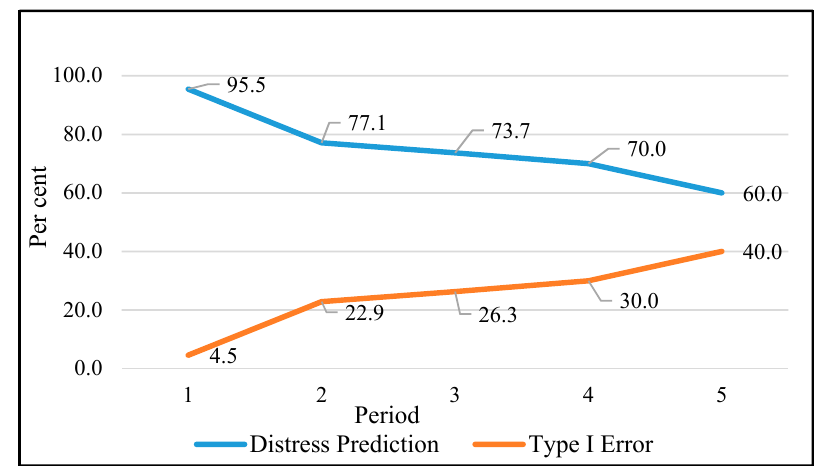
Figure 2. N period ahead prediction.